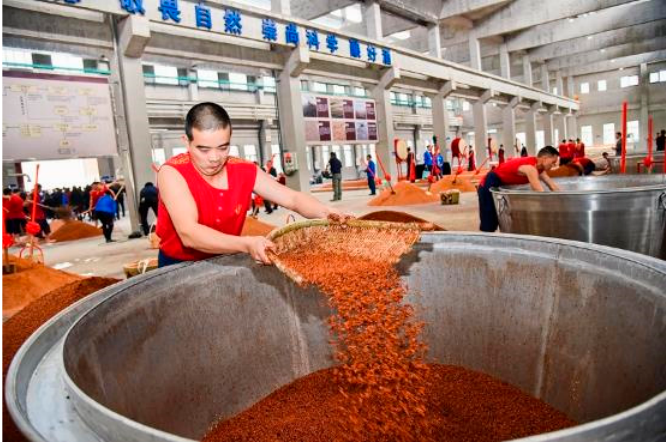
Figure 6. Traditional manual steamer-filling (kindly provided by Sichuan Langjiu Group Co., Ltd., Luzhou, China).